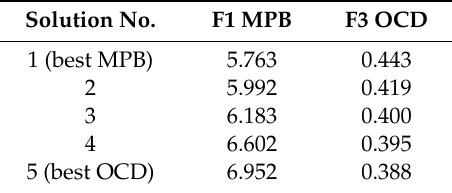
Table 8. Fitness functions for the pair F1–F3.